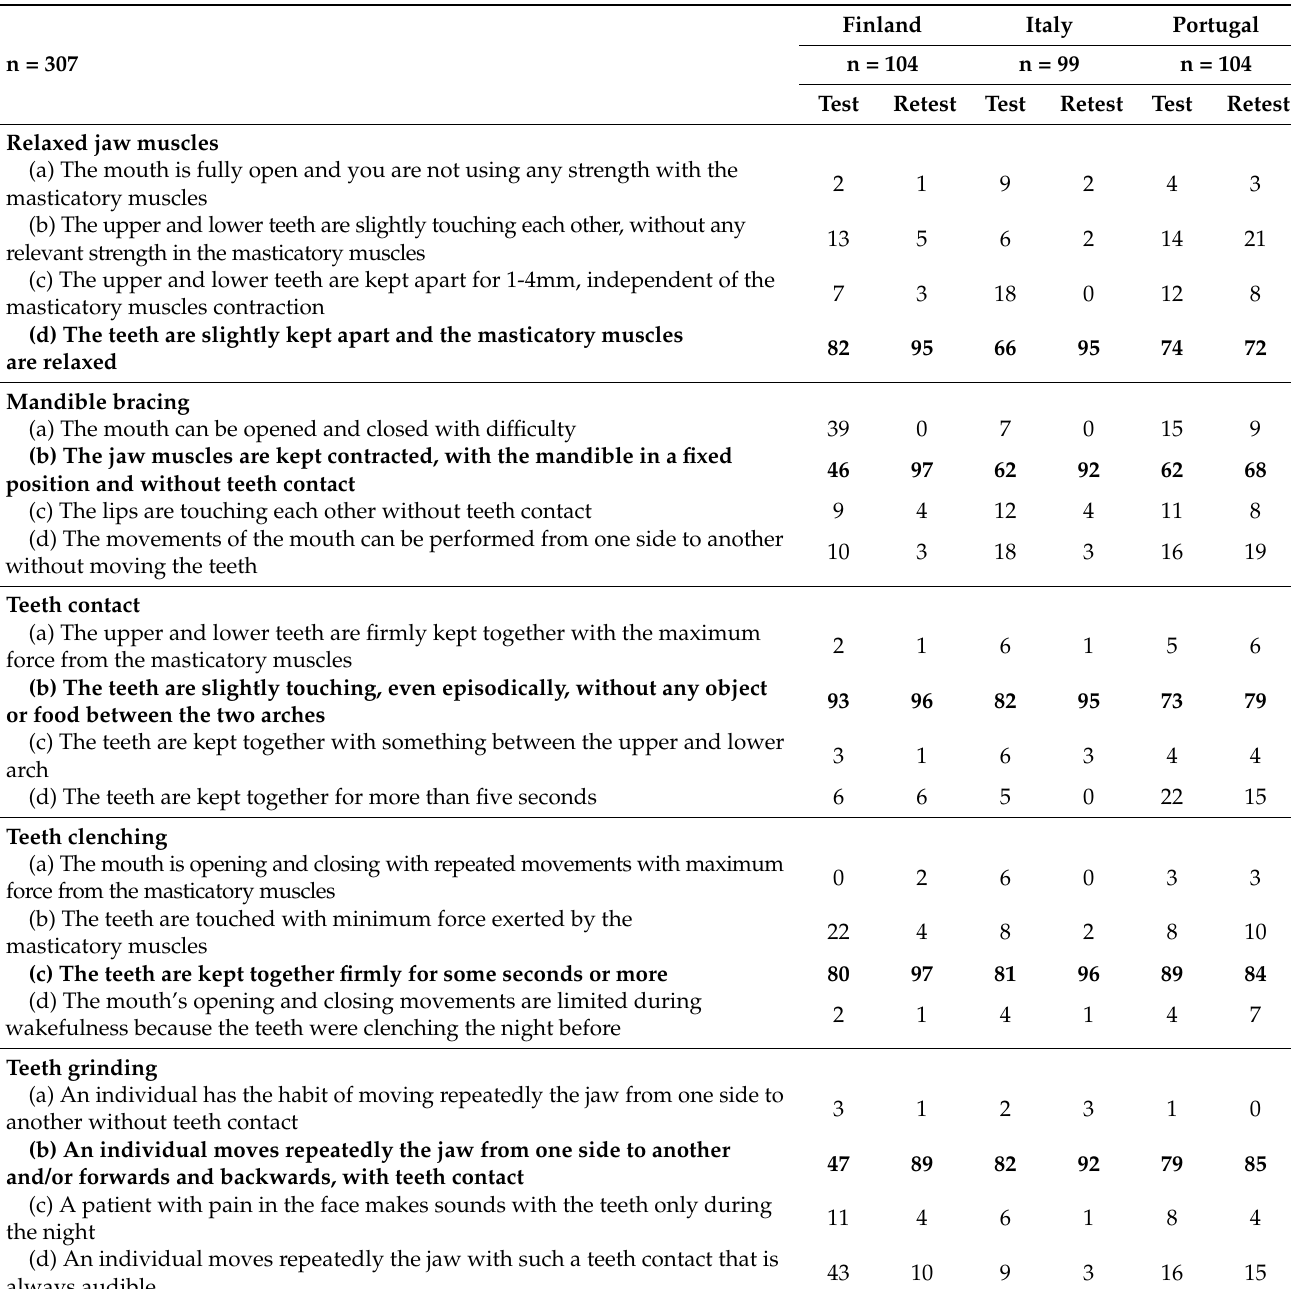
Table 1. Test-retest answers to the five studied items in Finland, Italy, and Portugal. Numbers of replies.